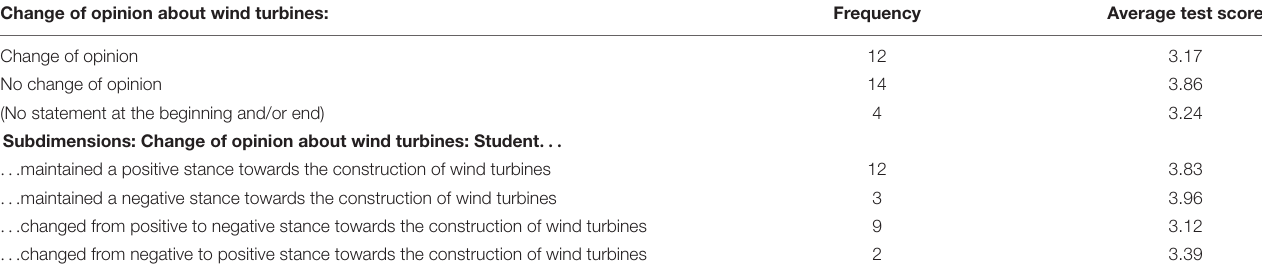
TABLE 7 | Change of